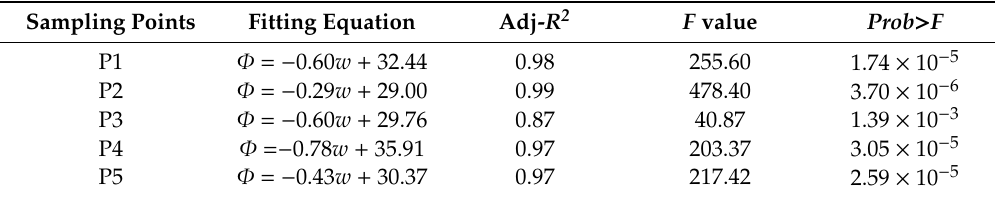
Table 2. The relationship between the internal friction angle and water content (7%, 10%, 13%, 16%, 19%, 22%, and 25%) for different sample points (P1, P2, P3, P4 and P5). Sampling Points